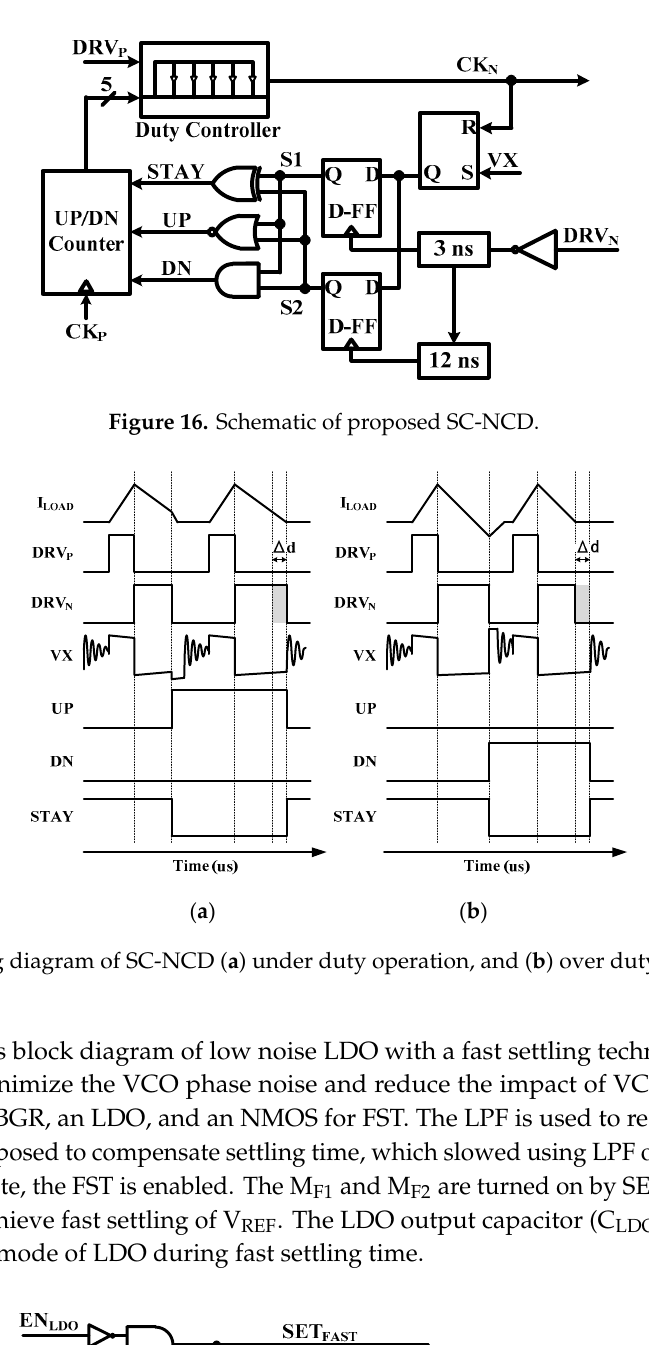
Figure 18. Block diagram of low noise LDO with a fast settling technique.